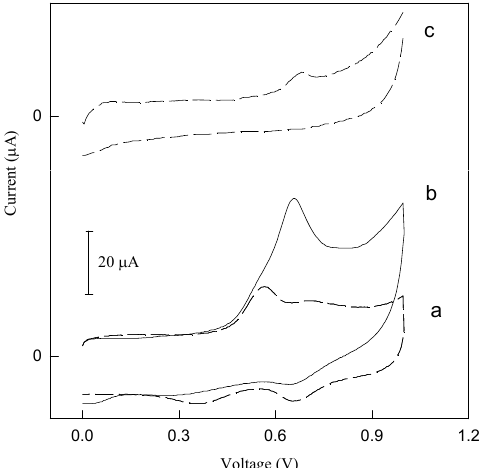
Figure 5. The cyclic voltammograms of CuCoHCF-modified graphite electrode in 0.5 M KCl solution (a) and in the presence of 300 μ M tryptophan (b), and tryptophan (c) on the bare graphite